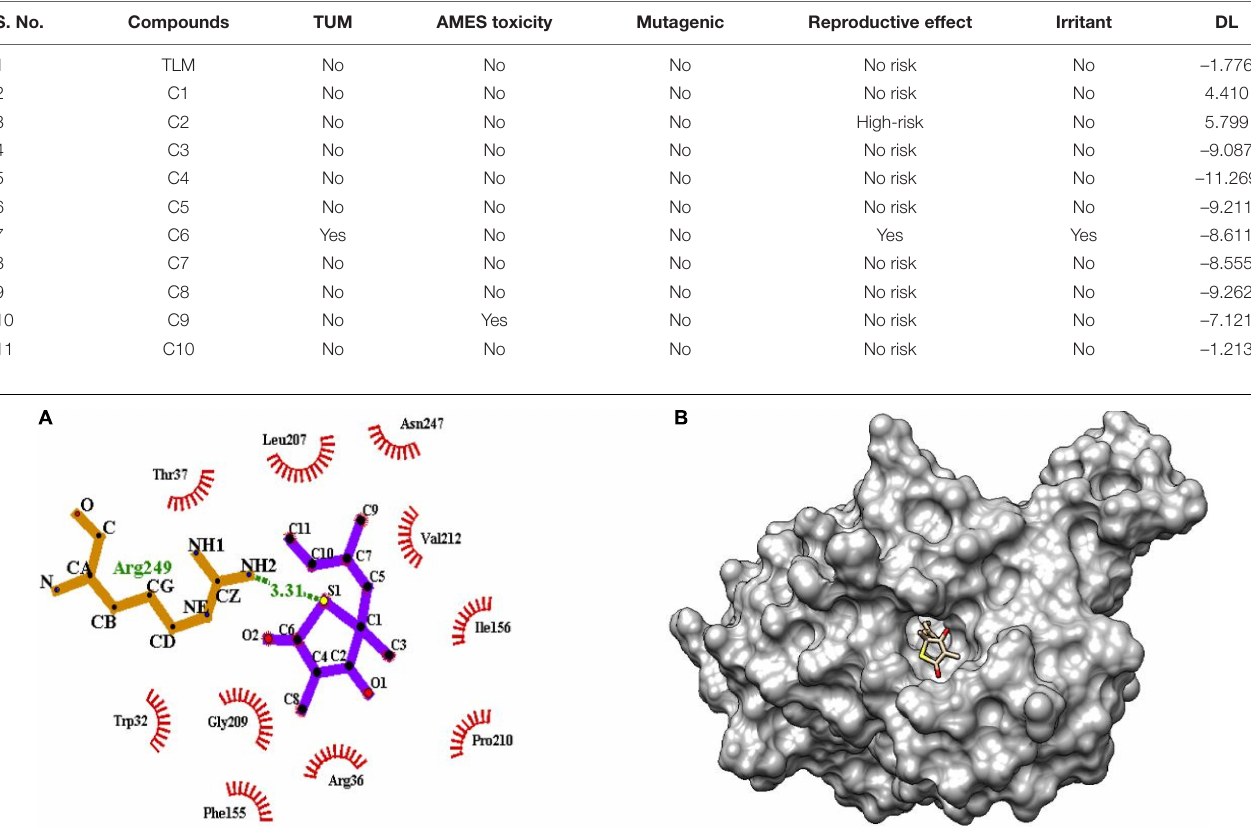
TABLE 3 | Toxicity analysis of known inhibitor TLM and lead molecules. S. No.